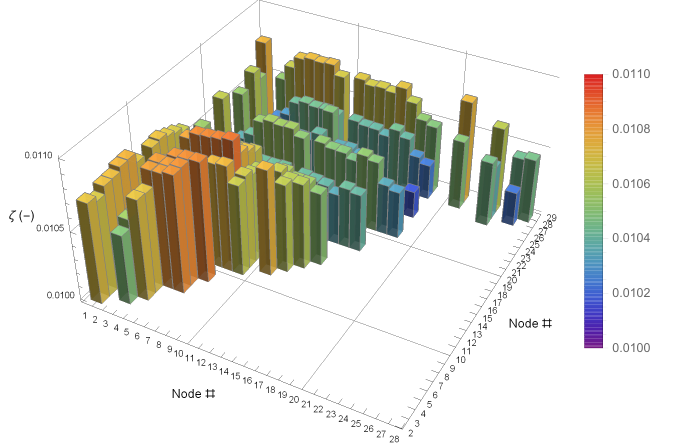
Figure 12. IEEE 39 bus: Damping ratios for VSCs with vector control connected to different